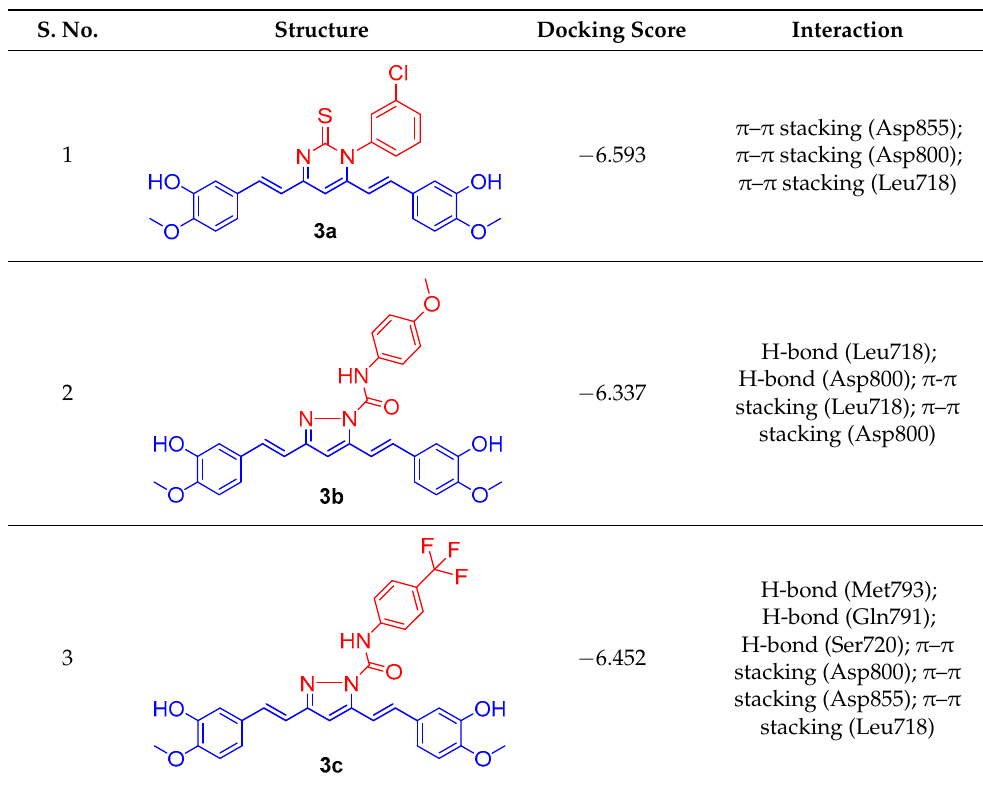
Table 1. The molecular docking scores and interaction of ligands 3a – c .